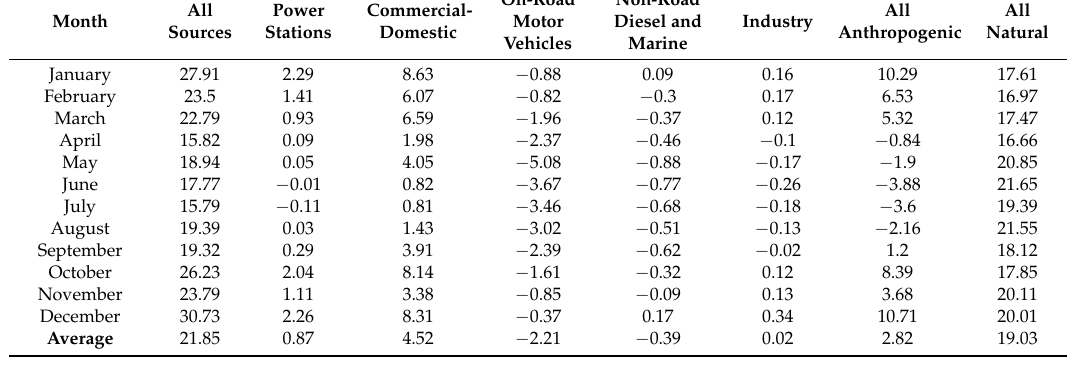
Table A3. Monthly average of daily maximum 1-hour predicted ozone concentration (ppb) in the Sydney east region for different months in 2008 under various emission scenarios.